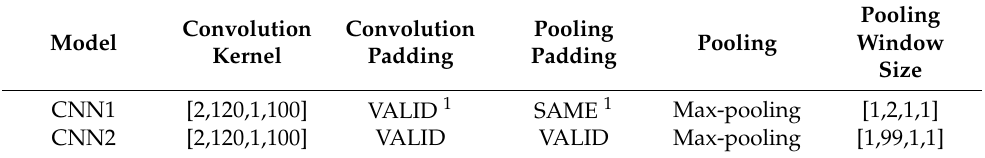
Figure 3. The convolutional neural network extracts character features from each word. The character embedding and the character type feature vector are computed through lookup tables. Then, they are concatenated and passed into the convolutional neural network (CNN). Table 1. CNN network convolution and pooling.